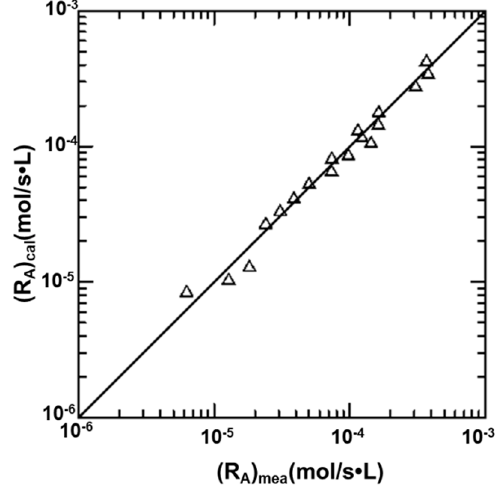
Figure 8. Regression confidence for R A .